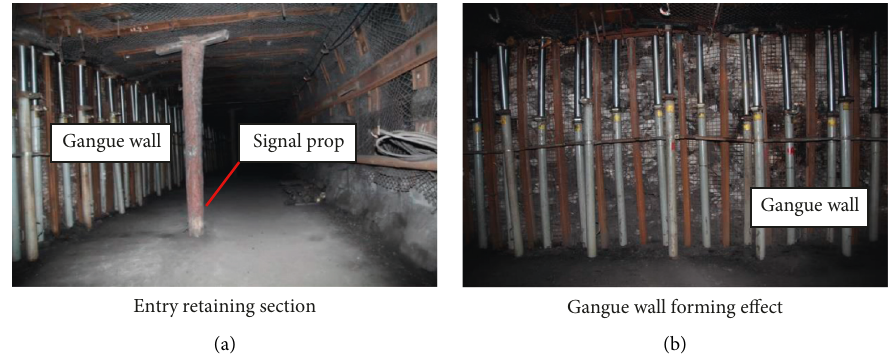
Figure 16: Field retaining effects. (a) Entry retaining section. (b) Gangue wall forming effect.